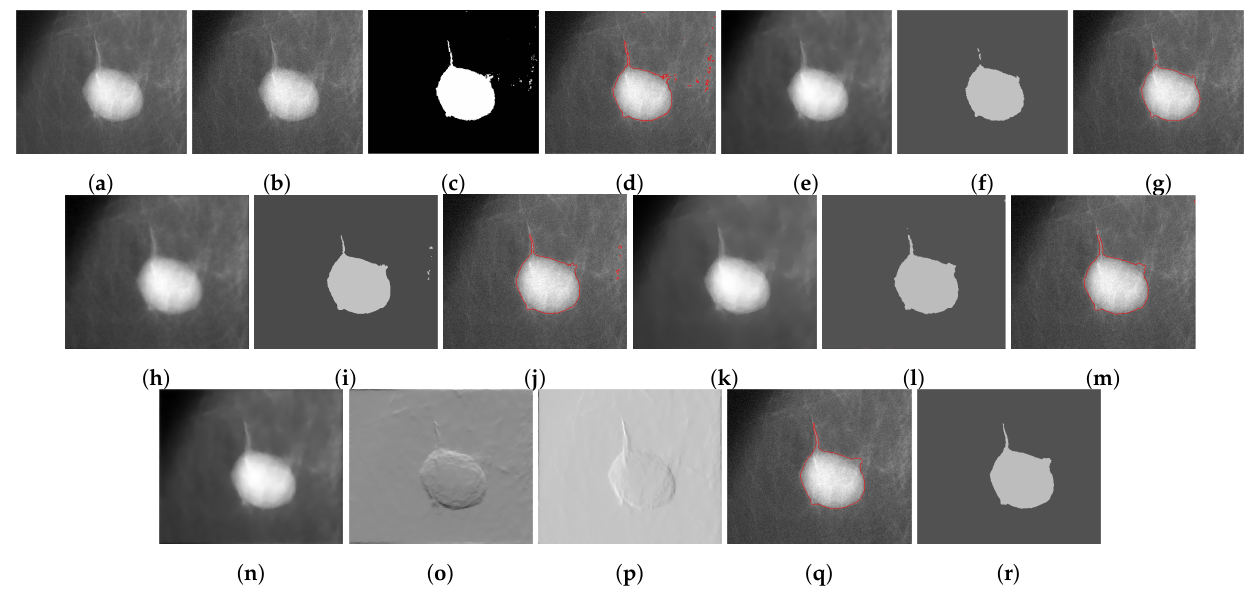
Figure 1. Results from an ultrasound image: ( a ) Clean image. ( b ) Noisy image used as input to the models. ( c ) Output of the CRCV model. ( d ) CRCV contour. ( e ) Output of CCZ. ( f ) CCZ after thresholding. ( g ) CCZ contour. ( h ) Output of CNC. ( i ) CNC after thresholding. ( j ) CNC contour. ( k ) Output of T-ROF. ( l ) T-ROF after thresholding. ( m ) T-ROF contour. ( n ) Output g of our model. ( o ) Output G x of our model. ( p ) Output G y of our model. ( q ) Ours after thresholding. ( r ) Our contour.